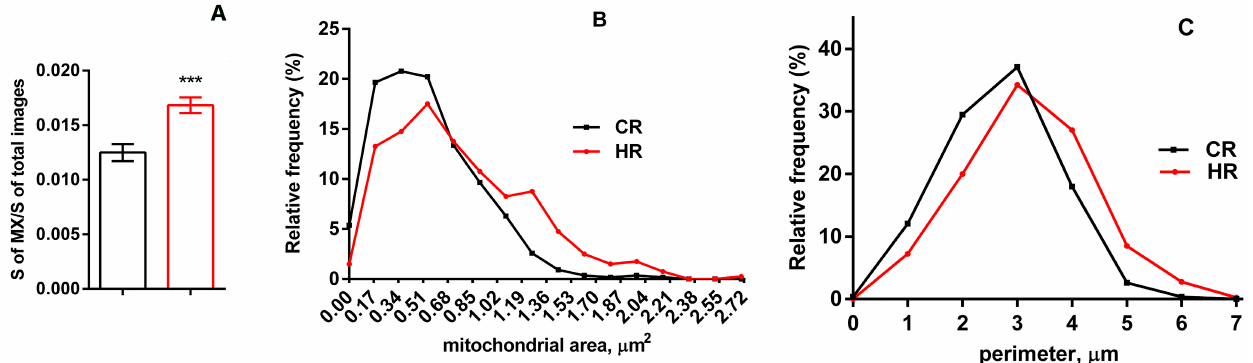
Figure 2. Morphometric parameters of heart mitochondria from the experimental rats. ( A ) The ratio of the mitochondrial area to that of the total image area (48 µ m 2 ). The number of examined images in each group was approximately 50. ( B ) A histogram of the distribution of the mitochondrial area in the groups. ( C ) A histogram of the distribution of the mitochondrial perimeter in the groups. The number of mitochondria analyzed in each group varied from 600 to 700. CR, control; HR, hyperthyroidism. *** p < 0.01, as compared with the control data (n =